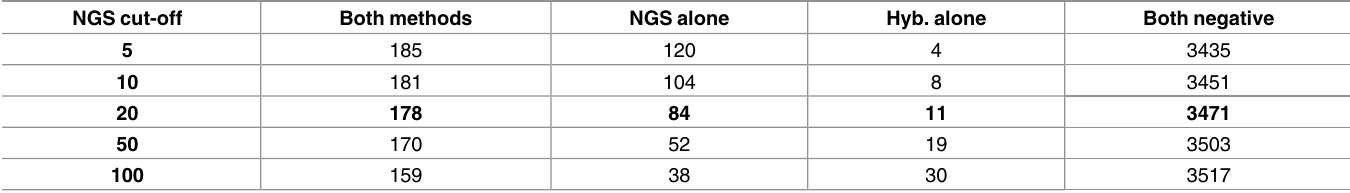
Table 2. The influence of NGS cut-off values on HPV detections made by NGS and hybridization. (The 20 read depth cut-off in bold ). NGS